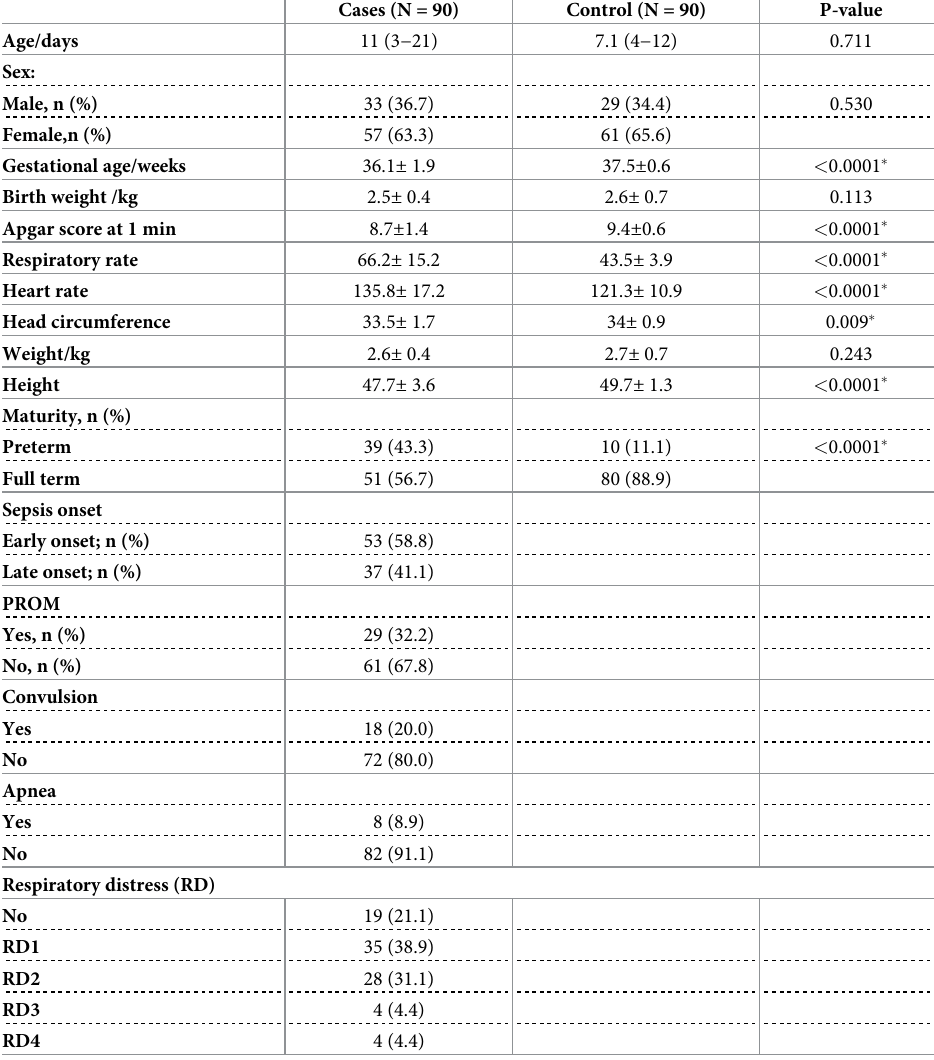
Table 1. Demographic and clinical data of neonates with sepsis and